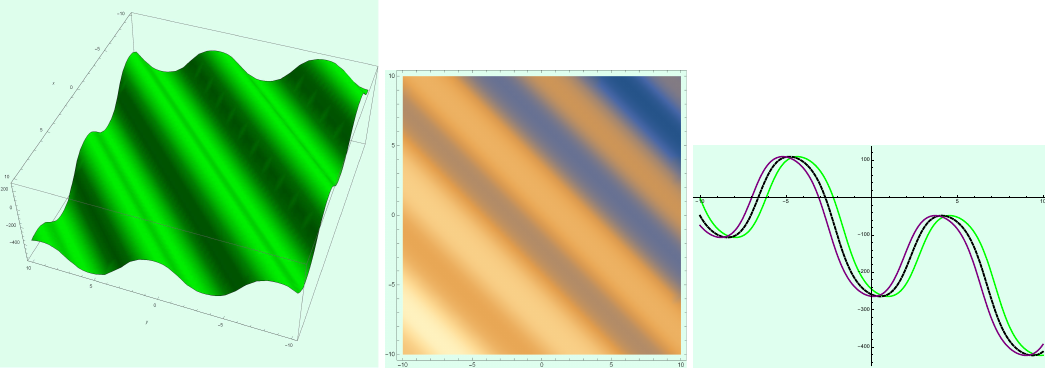
Figure 2. Evolution of periodic solution (20) at t = − 11 and z = 0.